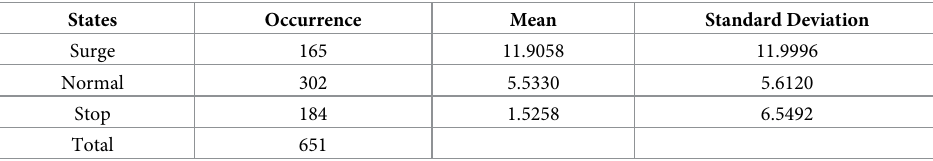
Table 3. Summary of international capital inflows in each